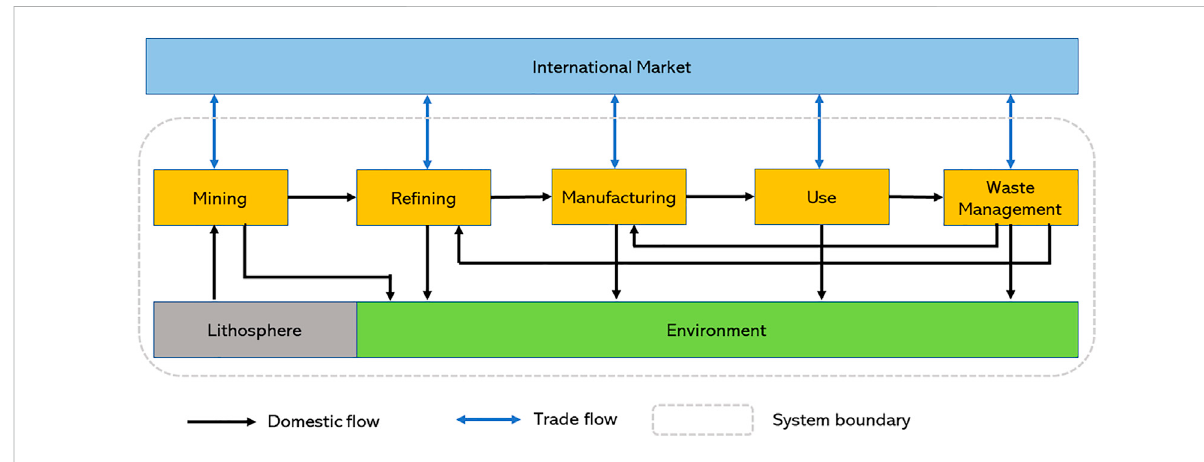
FIGURE 1 Overview ofthe supply chain ofmetals. This fi gure is basedon thestudies of Mulleret al. (2014), Chenet al. (2019), Sunetal. (2019),and Di etal.